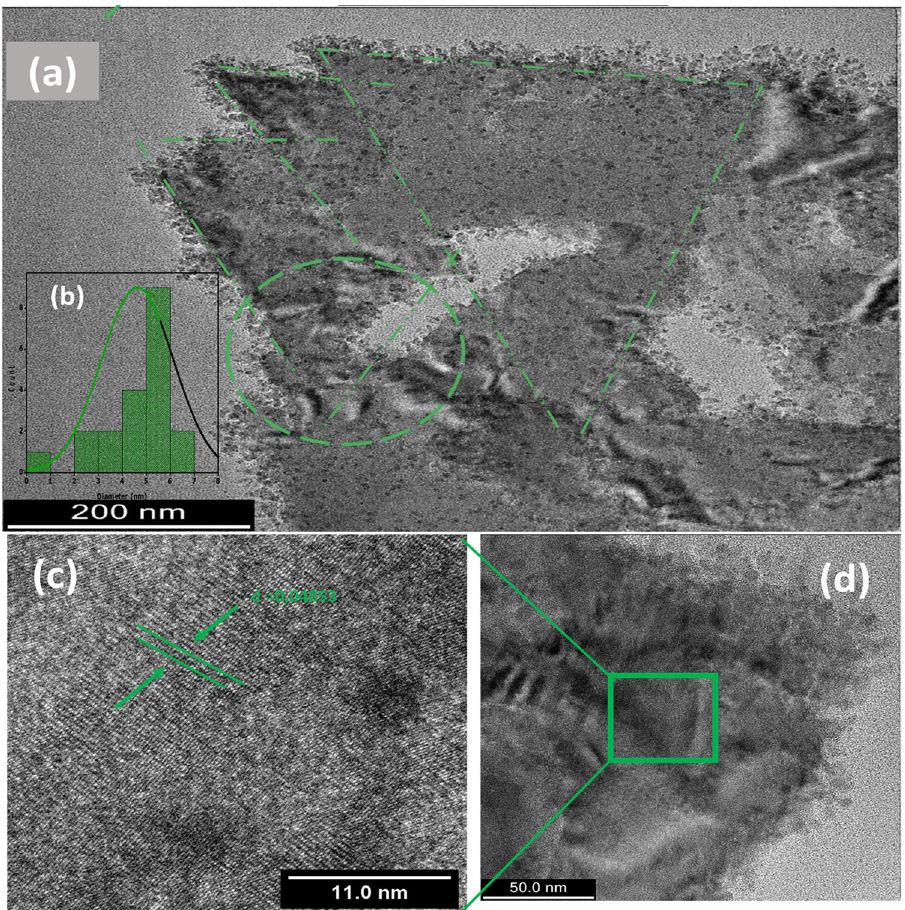
Figure 2. HRTEM images of the prepared hydronium jarosite nanoparticles. ( a ) Shows the2-D sheets decorated by nanoparticles, ( b ) particle size distribution histogram, ( c , d ) shows the lattice fringe zoomed out, ( e ) summary diagram of the ( a ), ( f ) shows the thick triangular sheet, ( g ) SAED